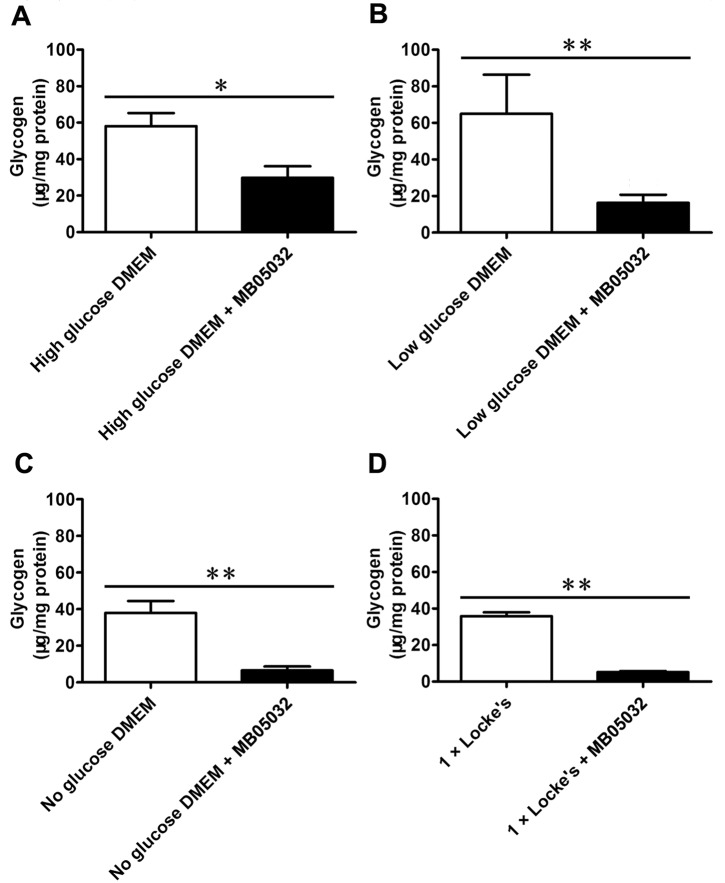
Glycogen level inside C. sinensis adults with or without MB05032 treatment.Adult flukes were respectively maintained on high, low, and no glucose DMEM (A, B, and C), as well as 1 × Locke’s (D) with or without the addition of MB05032. Glycogen level was detected at 24 h of feeding. Differences between two groups were evaluated by student’s t test. *P < 0.05 and **P < 0.01 were represented as statistical significance.